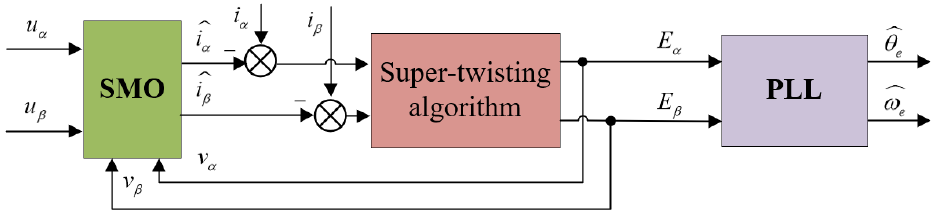
Figure 3. ST-SMO structure block diagram.